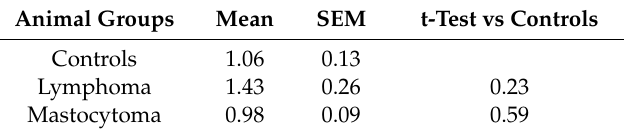
Table 3. OSi NE (DROMS/FRAP)×1000